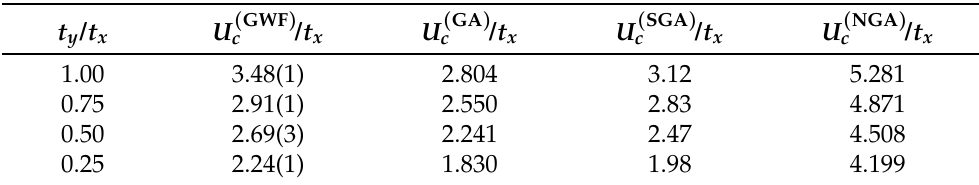
Table 1. Critical values of the Hubbard repulsion U ( GWF ) c obtained from VMC simulations (with standard deviations for the last digit specified in parentheses) compared with the upper ( U ( GA ) c ) and the upper ( U ( NGA ) c ) bound following from the Gutzwiller Approximation (GA) and the Néel-state Gutzwiller Approximation (NGA). The results obtained from the Statistically-consistent Gutzwiller Approximation (SGA) are also given. The system size is defined by N x = N y = 10 for VMC ∞ simulations; the remaining results correspond to the limit of N x = N y →